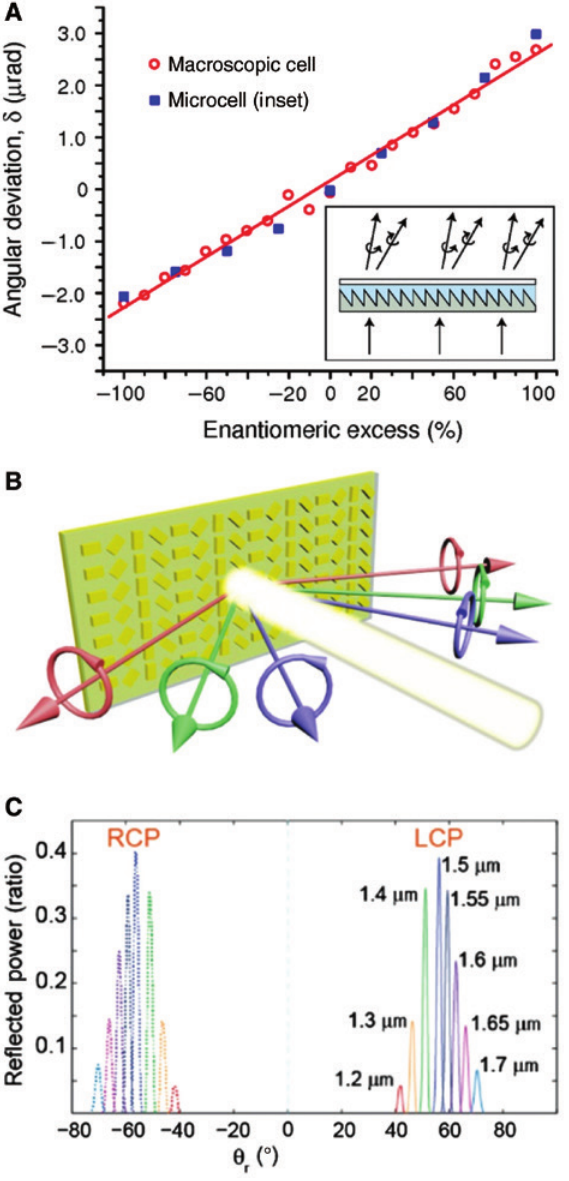
Figure 7: (A) Angular deviation of two refracted beams of opposite helicity in a Fresnel lens filled with limonene at the micron-scale [57]. (B) Schematic of the phase gradient metasurface exhibiting the photonic spin Hall effect [58]. (C) Reflected power of the phase gradient metasurface for two opposite circularly polarized lights. Reprinted with permission from Ref. [57], copyright 2006, American Physical Society; Ref. [58], copyright 2015, Optical